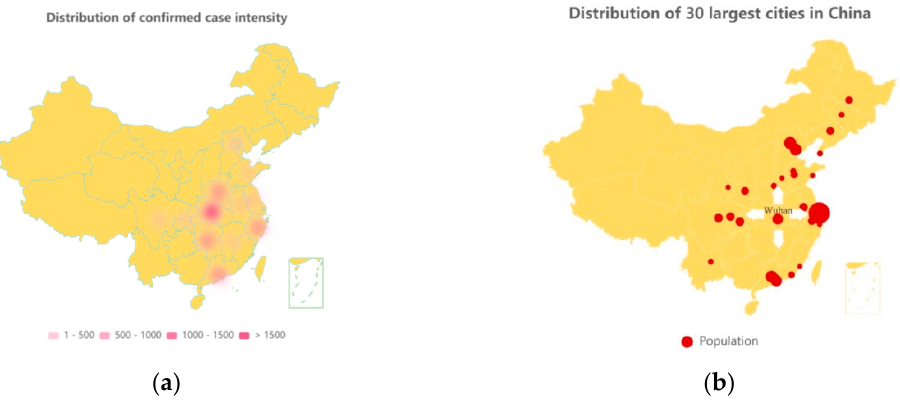
Figure 3. ( a ) Geographical distribution of confirmed cases; ( b ) geographical distribution of the 30 largest cities in China (Wuhan is specifically